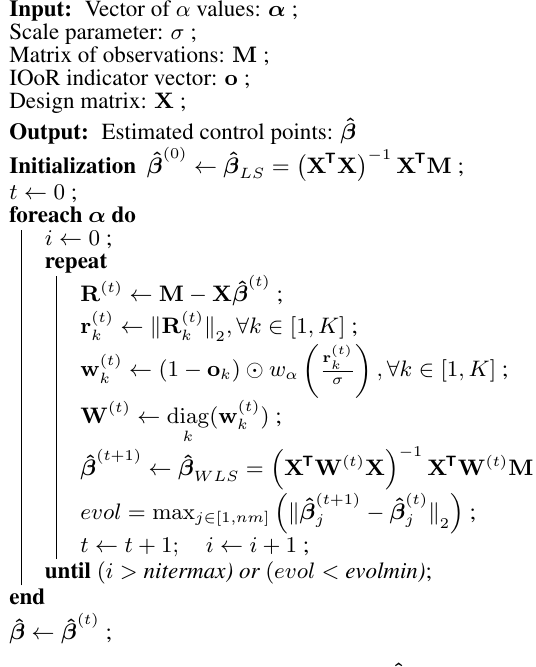
Algorithm 1: Robust estimation of ˆ β with